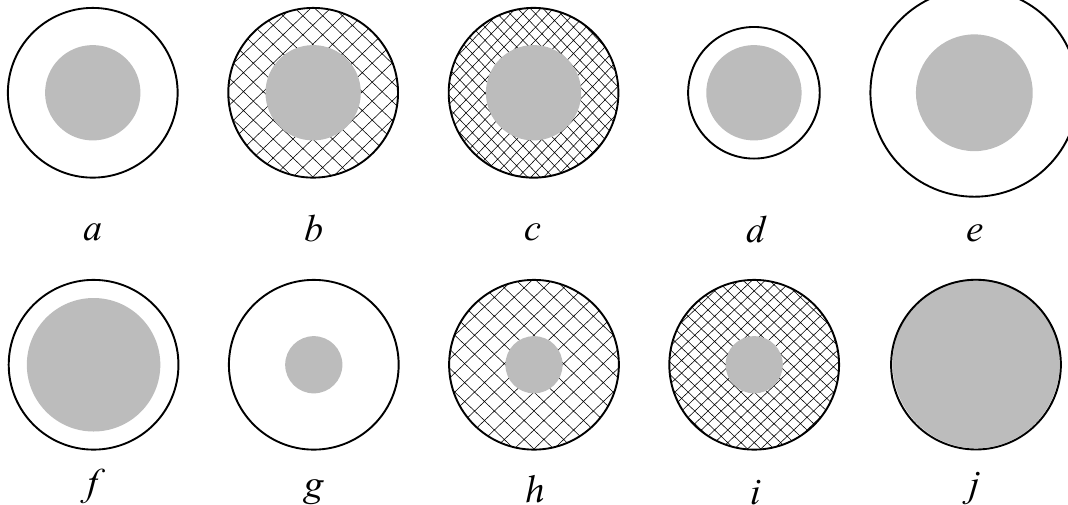
Figure 1. Morphologies of the different synthesized core-shell polymer nanoparticles. Medium core size with medium shell thickness and styrene content of ( a ) 80%, ( b ) 90%, and ( c ) 99% in the shell. Medium core size with a ( d ) thinner and ( e ) thicker shell of styrene content of 80% and different overall particle size. Different core size while keeping the overall size constant with respect to ( a ), leading to a ( f ) thinner and ( g ) thicker shell of styrene content of 80%. Same morphology as ( g ) but with a styrene content of ( h ) 90% and ( i ) 99% in the shell. ( j ) Core-only latex